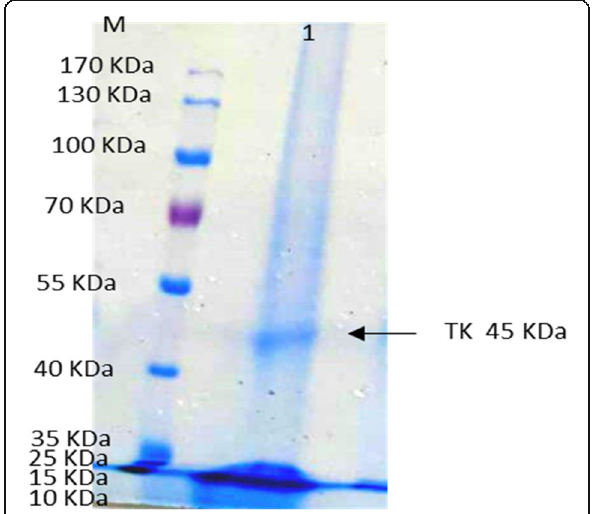
Fig. 3 Commassie blue stained SDS-PAGE profile of total proteins purified (TK) for Torulaspora delbrueckii by dialysis M: marker protein lane 1 TK band (45